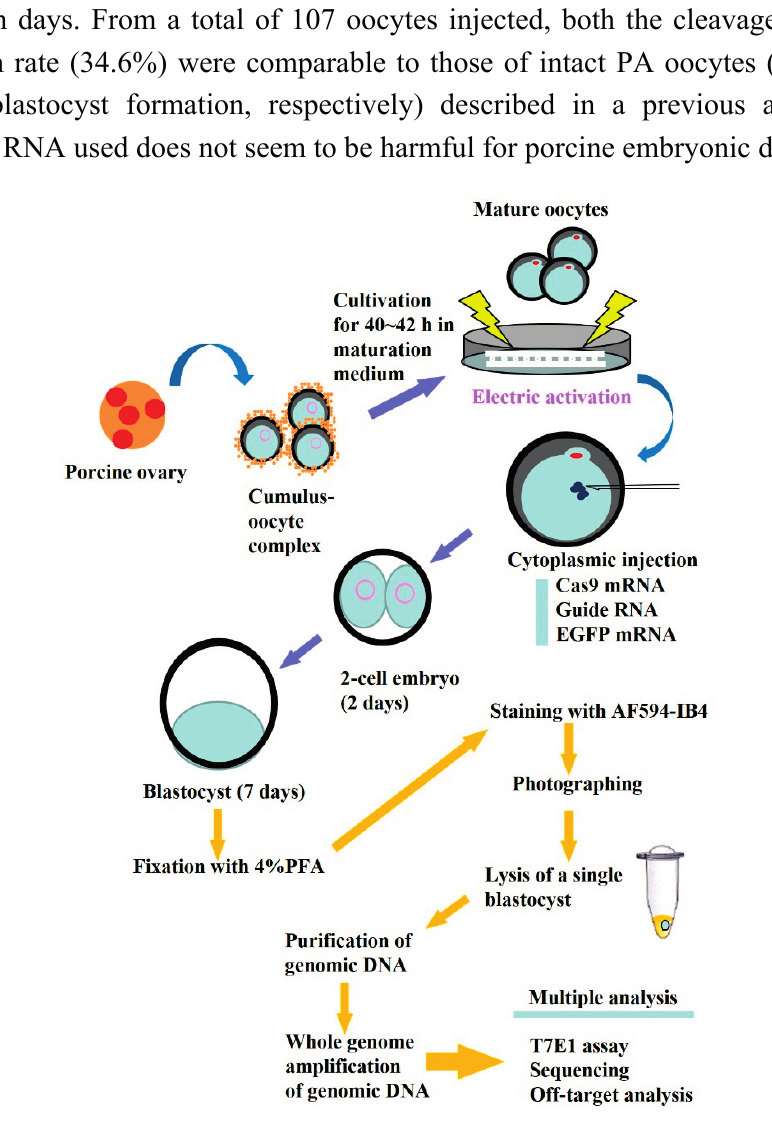
Figure 1. Schematic representation of a single blastocyst-based assay after isolation of porcine oocytes from an ovary, in vitro maturation, electric activation, and subsequent cytoplasmic injection with CRISPR/ Cas9 -related mRNA and EGFP